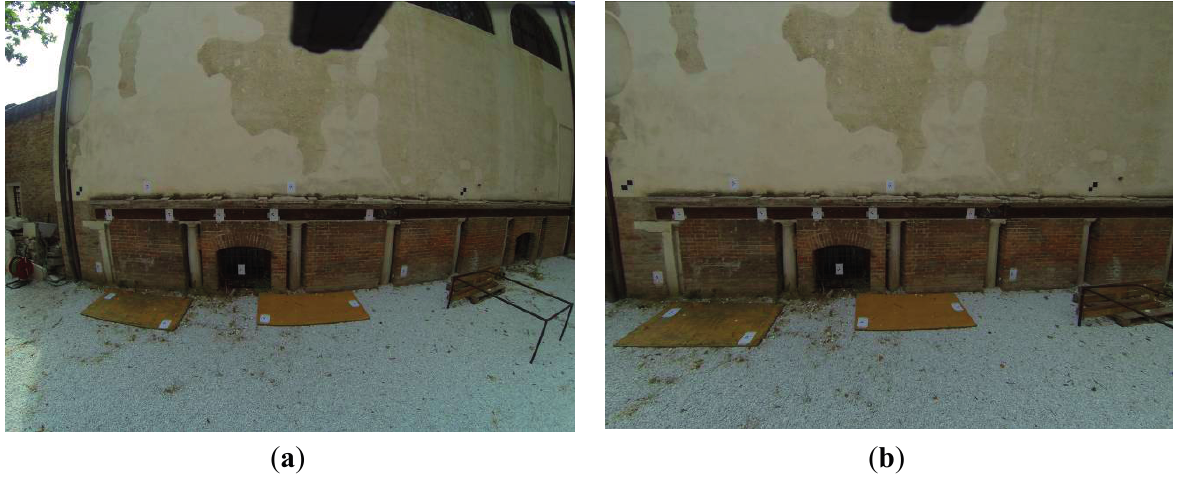
Figure 1. The ( a ) distorted image from the GoPro Hero 3 Camera and its ( b ) undistorted version. The undistorted image has been created using the special remapping function of OpenCV.